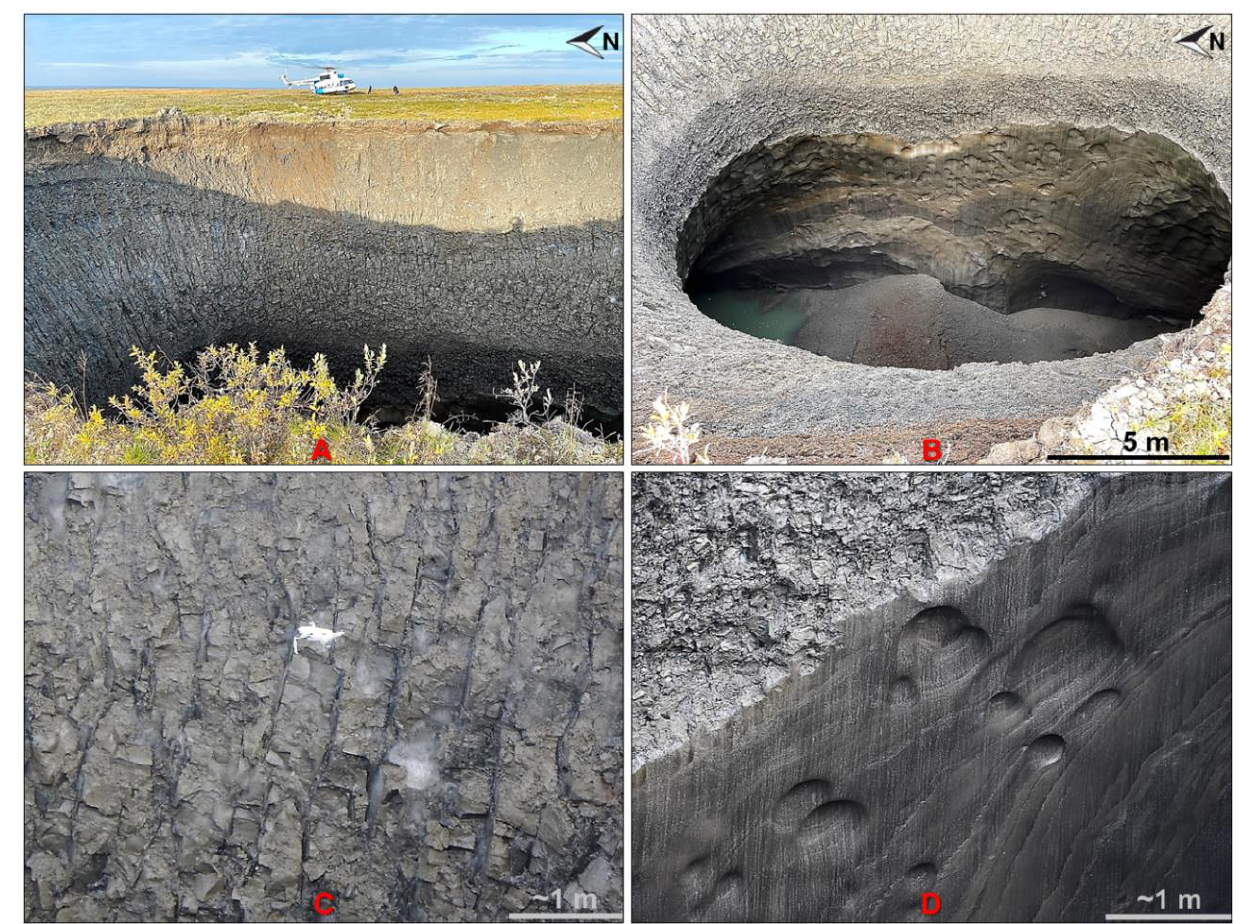
Figure 4. Features of the structure of the crater walls (photos by Vasily Bogoyavlensky ( A , B ), Roman Nikonov ( C ) and Evgeniy Chuvilin ( D ), August 26, 2020).